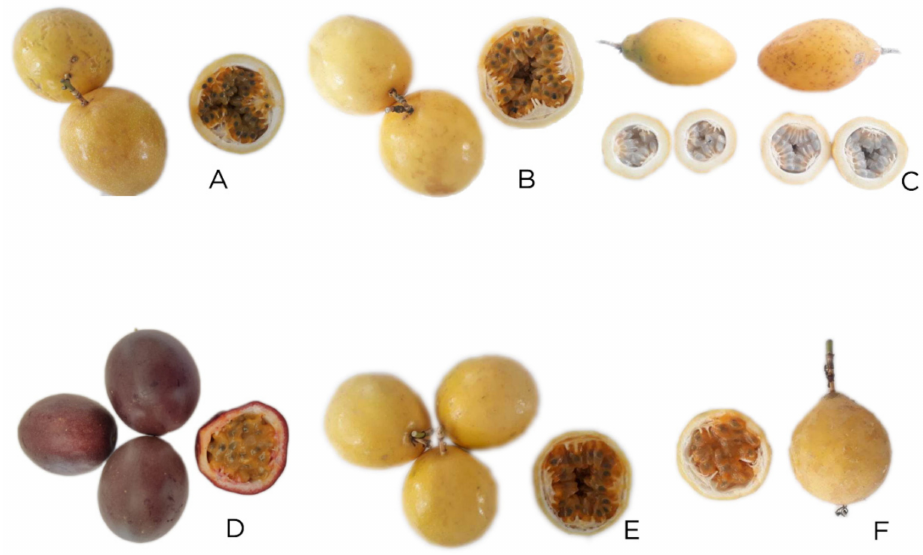
Figure 2. Passion fruit germplasm grown in Ecuador. ( A ) INIAP 2009, ( B ) P10, ( C ) Sweet passion fruit, ( D ) Gulupa, ( E ) POR1, and ( F )